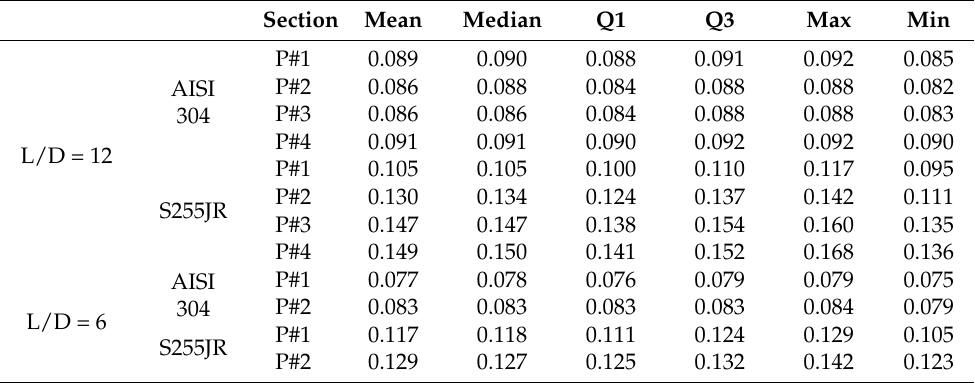
Table 5. Main statistics of the Rdq